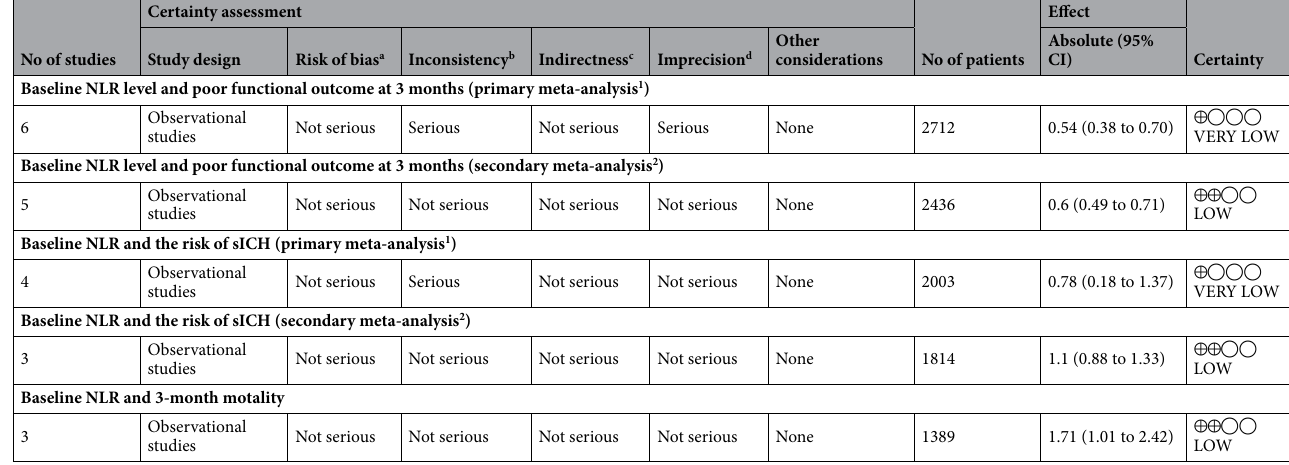
Table 1. Qualitative assessment of results of metanalysis for NLR in AIS patients outcome after reperfusion therapy (GRADE analysis). CI confidence interval. a Risk of bias: based on Newcastle-Otawa Scale for cohort studies and blind assay assessment reported. b Inconsistency: based on the evaluation of heterogeneity (Q statistic and I2 statistic) in this meta-analysis. c Indirectness: refers to how well the evidence included in the review answers the review question related to population, intervention, comparator or outcome used in included studies. d Imprecision: results are considered imprecise when studies include only relatively few participants (a total number of participants is less than 400 for continuous outcome information is considered to be insufficient) and when 95% confidence interval include no effect and the upper confidence limit cross the minimal important difference. 1 Primary meta-analysis pooled all the studies comprising the outcome into analysis. 2 Secondary meta-analysis excluded one study which brought high heterogeneity before